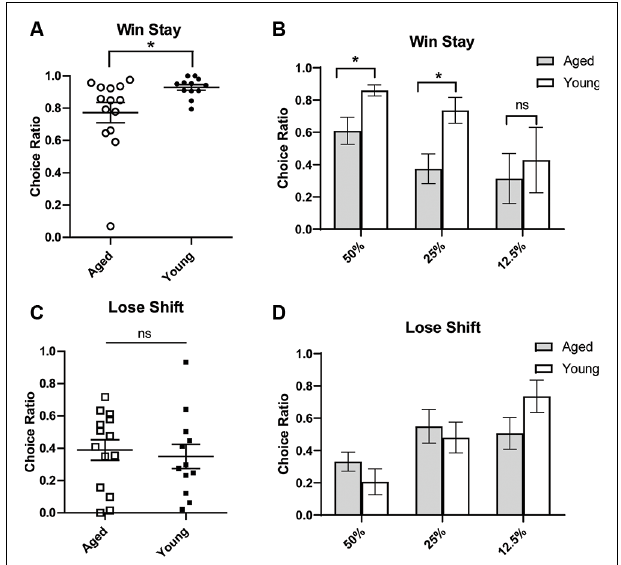
FIGURE 2 | Win-stay (A,B) and lose-shift choice ratios (C,D) . A win is defined as a choice for the large/risky lever that resulted in a reward. (Top) The choice ratio for win-stay represents the ratio of choices of the risky (as opposed to safe) lever following a “win” risky trial. (A) Individual rat win-stay choice ratios for aged and young groups. Aged rats showed significantly reduced win-stay ratios compared to young rats (independent t -test, t (24) = 2.42, p = 0.01). (B) This effect was specifically driven by a decrease in the choice ratio in the 50% and 25% blocks ( p’s < 0.05). (Bottom) A loss is defined as a choice for the large/risky lever that did not yield a reward. The choice ratio for lose-shift represents the ratio of choices for the small/certain lever after a “loss.” (C) Individual rat lose-shift choice ratios for aged and young animals. There was no difference in lose-shift behavior by age group (independent t -test, t (24) = 0.69, p = 0.25). (D) There was no difference in the lose-shift choice ratio in 50% and 25% blocks. Open symbols: aged rats, n = 16; Closed symbols: young rats, n = 12. * p < 0.05; ns, not significant, p > 0.05.